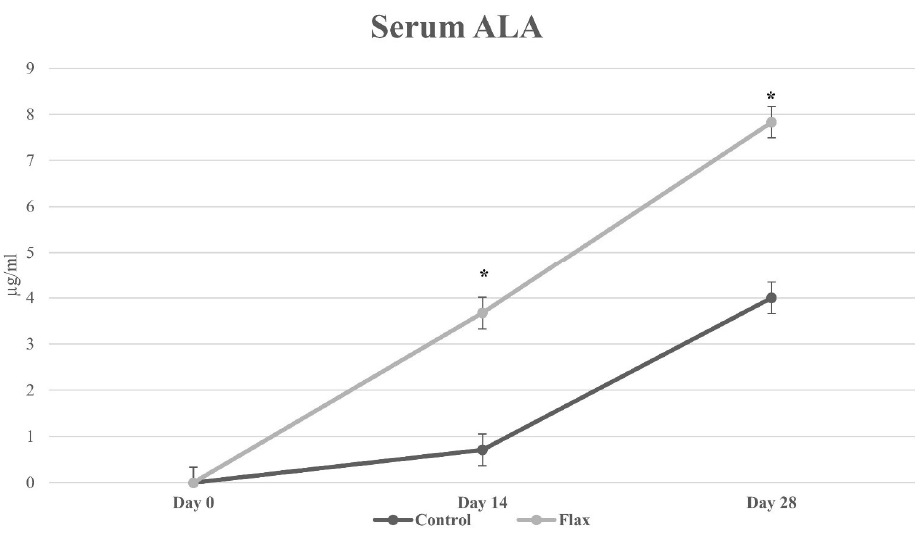
Figure 1. Average serum alpha-linolenic acid (ALA) concentrations in adult cats fed control and 2.6% as-is whole ground flaxseed diets. * Denotes a significant ( p < 0.05) difference between diets. Hematology and serum chemistry values were within normal healthy reference range for all cats (Table 4). Cats consuming flaxseed exhibited greater ( p < 0.05) serum potassium and platelets, while control-fed cats had lower ( p < 0.05) serum mean corpus- cular hemoglobin concentration, compared with flaxseed-supplemented cats. Table 4. Hematology and serum chemistry results of adult cats fed control and 2.6% as-is ground flaxseed diets.